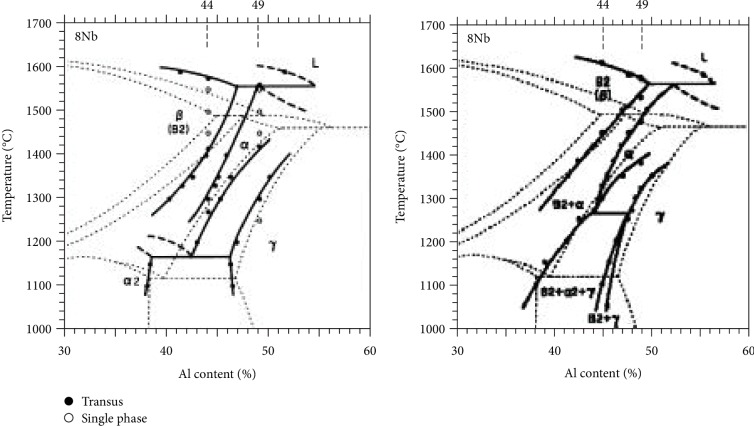
Nb-containing Ti-Al quasiphase diagrams [33]: (a) 8% Nb; (b) 10% Nb.